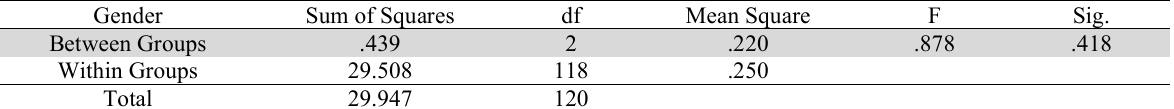
The results of ANOVA test for the effect of age Gender Sum of Squares df Mean Square F Sig. Between